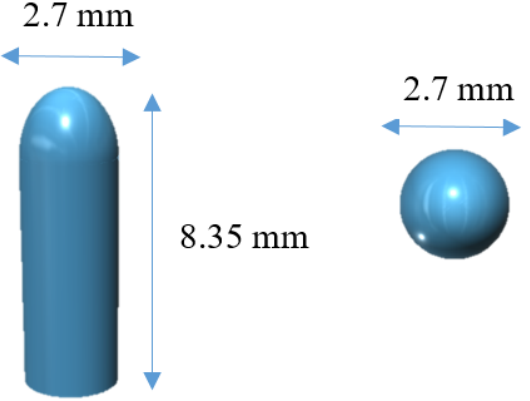
Figure 1. 3D model of the suppositories from different angles.